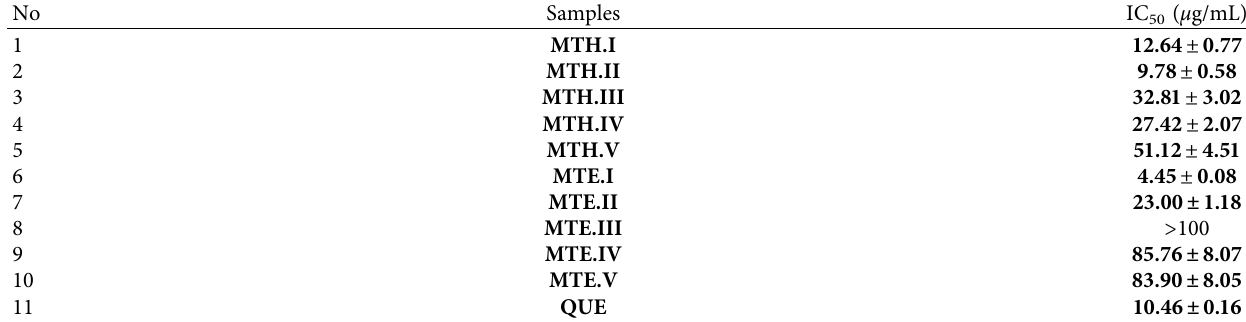
Table 2: Te anti-infammatory activity of all fractions of M. tricolor.